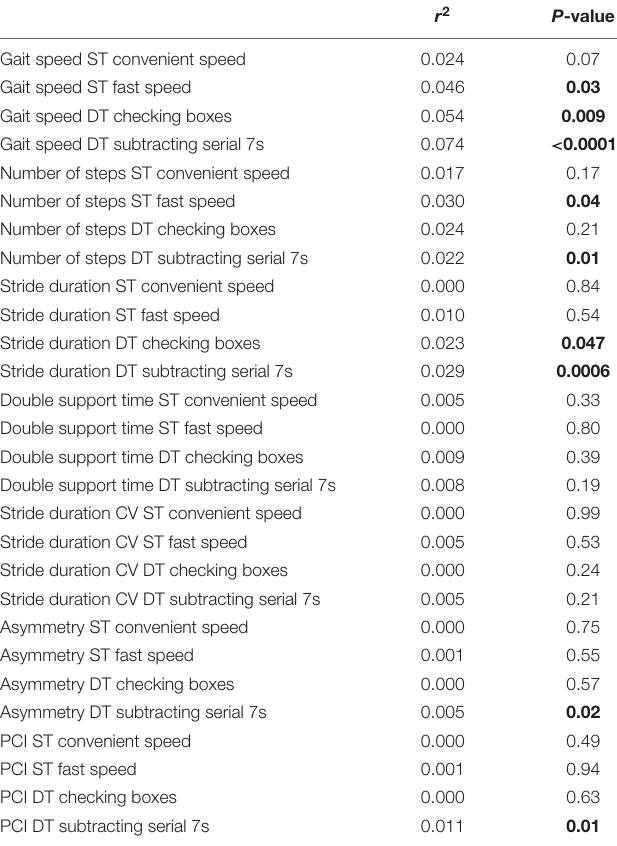
TABLE 2 | Correlation values between quantitative gait parameters and the delta Trail-Making